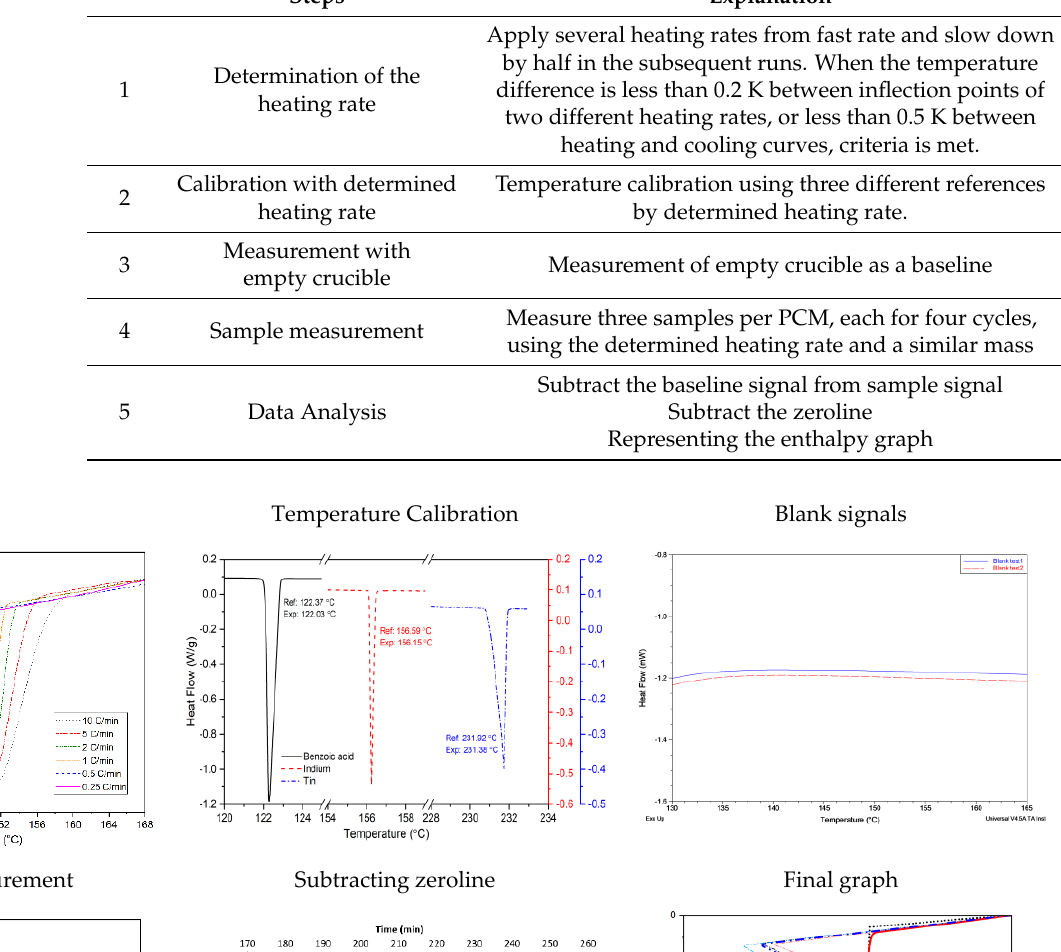
Figure 13. Baseline correction: ( a ) base-line construction (zeroline); ( b ) Effect of baseline correction on the enthalpy curve (personal data). For a mixture of different PCMs, the combination of phase equilibrium study with DSC results provides one with a robust method for determining the fusion heat and phase transition range by understanding the solid – liquid fraction at any temperature and re- lated storage capacity in order to have a better system storage design. The storage density in any temperature range is a function of mixture and temperature range [8]. Thus, repre- senting the phase diagram and eutectic composition is essential for eutectic mixture of PCMs [51]. Rathgeber et al. [29] represented the enthalpy – temperature plot for four PCMs, namely, (RT58, bischofite, D-mannitol and hydroquinone) using three different calorimet- ric methods. The applied methods were DSC, T-history and pilot plant set-up. DSC, T-